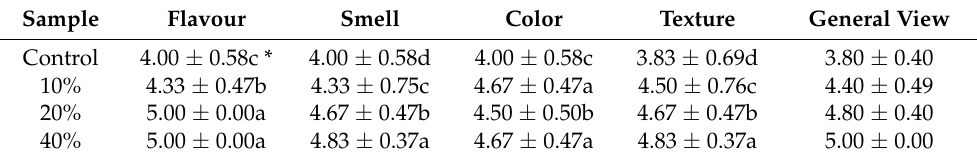
Table 4. Sensorial properties of bread samples enriched with chufa flour at different concentrations.